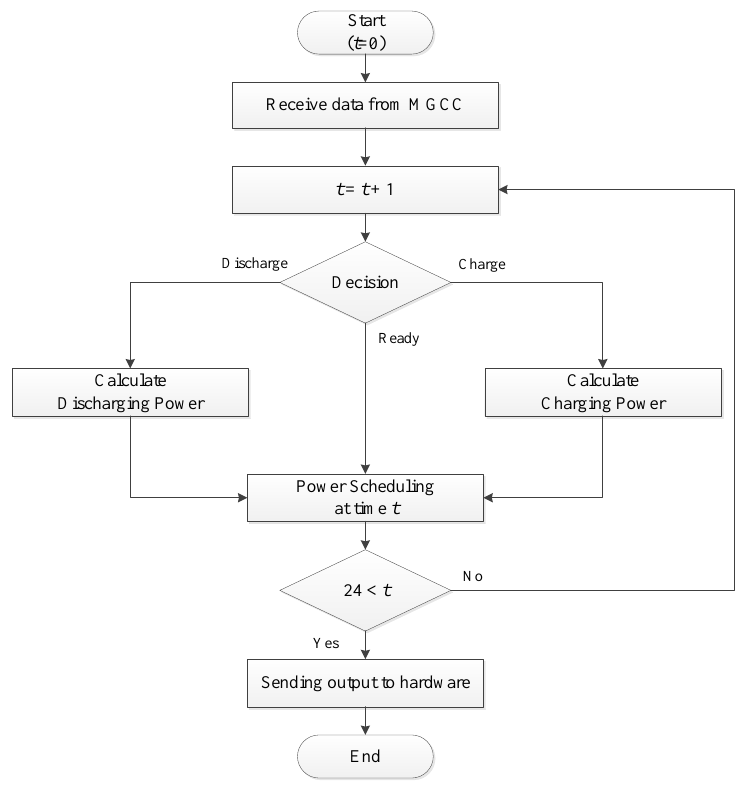
Figure 3. Flow chart of battery energy storage system (BESS) scheduling algorithm.